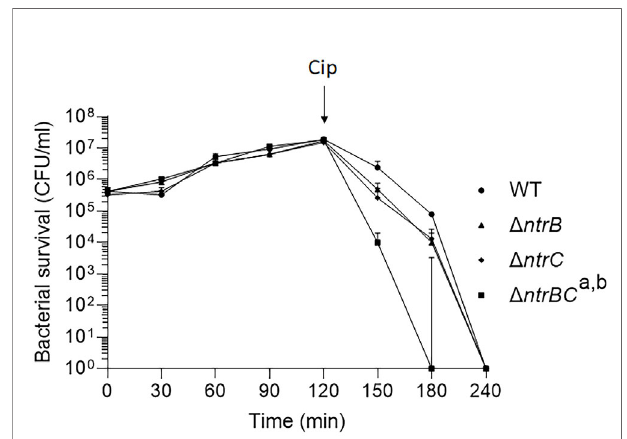
FIGURE 1 | Mutationofthe nitrogenregulatorytwo-componentsystem, NtrBC, increased P. aeruginosa susceptibilityto cipro fl oxacin. Killcurveswereperformedin MHB after additionof25µg/mlcipro fl oxacinat t = 120min.Dataarereportedas mean± standarderror ofthemean(SEM) from threeindependent experiments performedinduplicate. a,b P < 0.05att=150minandt =180 minaccording to KruskalWallisnonparametrictest followedbyDunn ’ s post-hoc